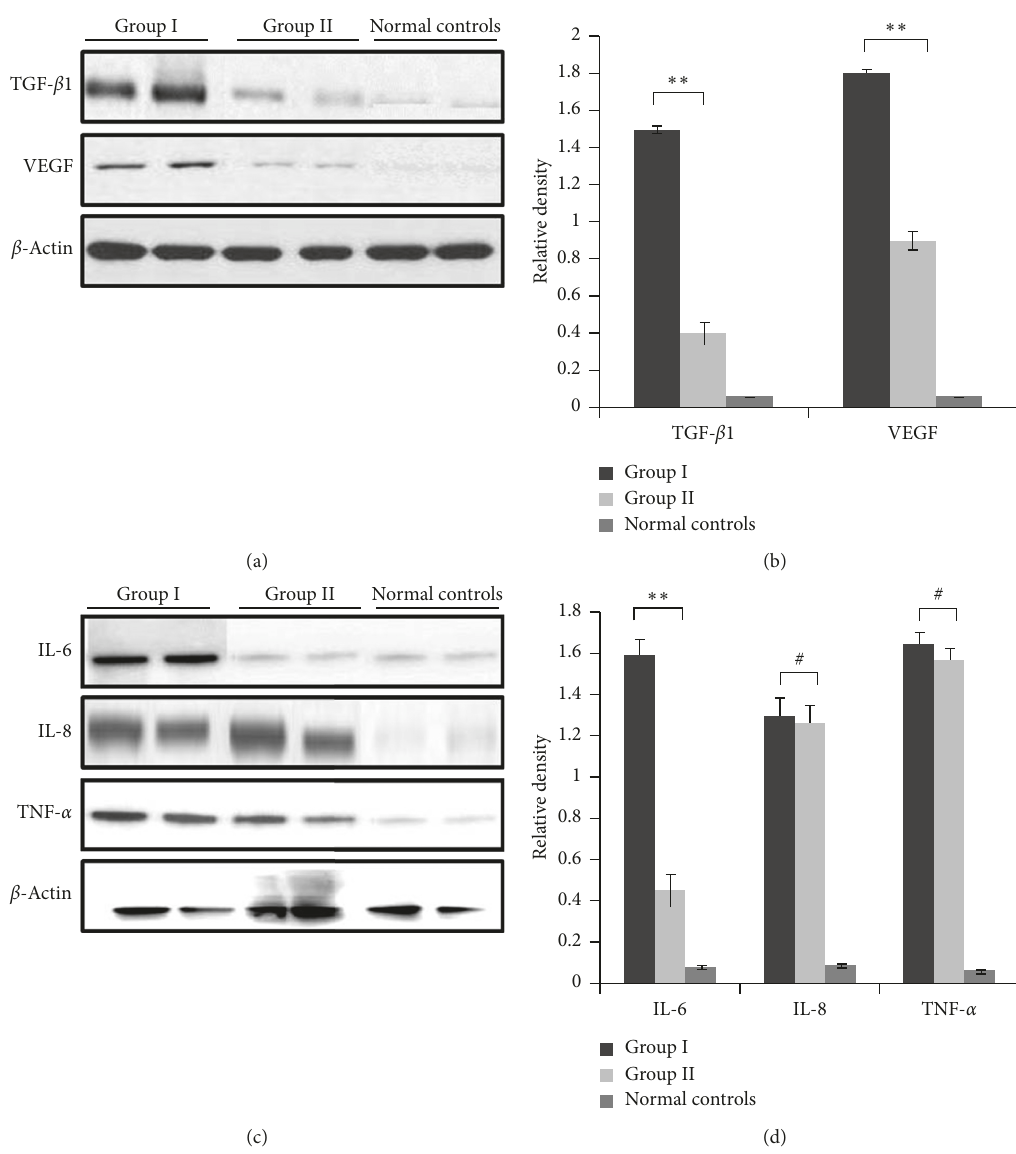
Figure 3: MMC decreases the expression of pro-inflammatory cytokines in pterygium tissues. (a, b) Expression of TGF- β 1 and VEGF proteins in pterygium tissues from group I and group II patients was determined via western blotting analysis. (a) Data are also shown as representative of three independent experiments (b) ∗∗ P < 0 . 01. (c, d) Expression of inflammatory factors such as IL-6, IL-8, and TNF- α was evaluated via western blotting analysis. Data are shown as representatives (c) and also are shown as representative of three independent experiments (d) ∗∗ P < 0 . 01 and # P > 0 . 05. Normal corneal tissues were used as